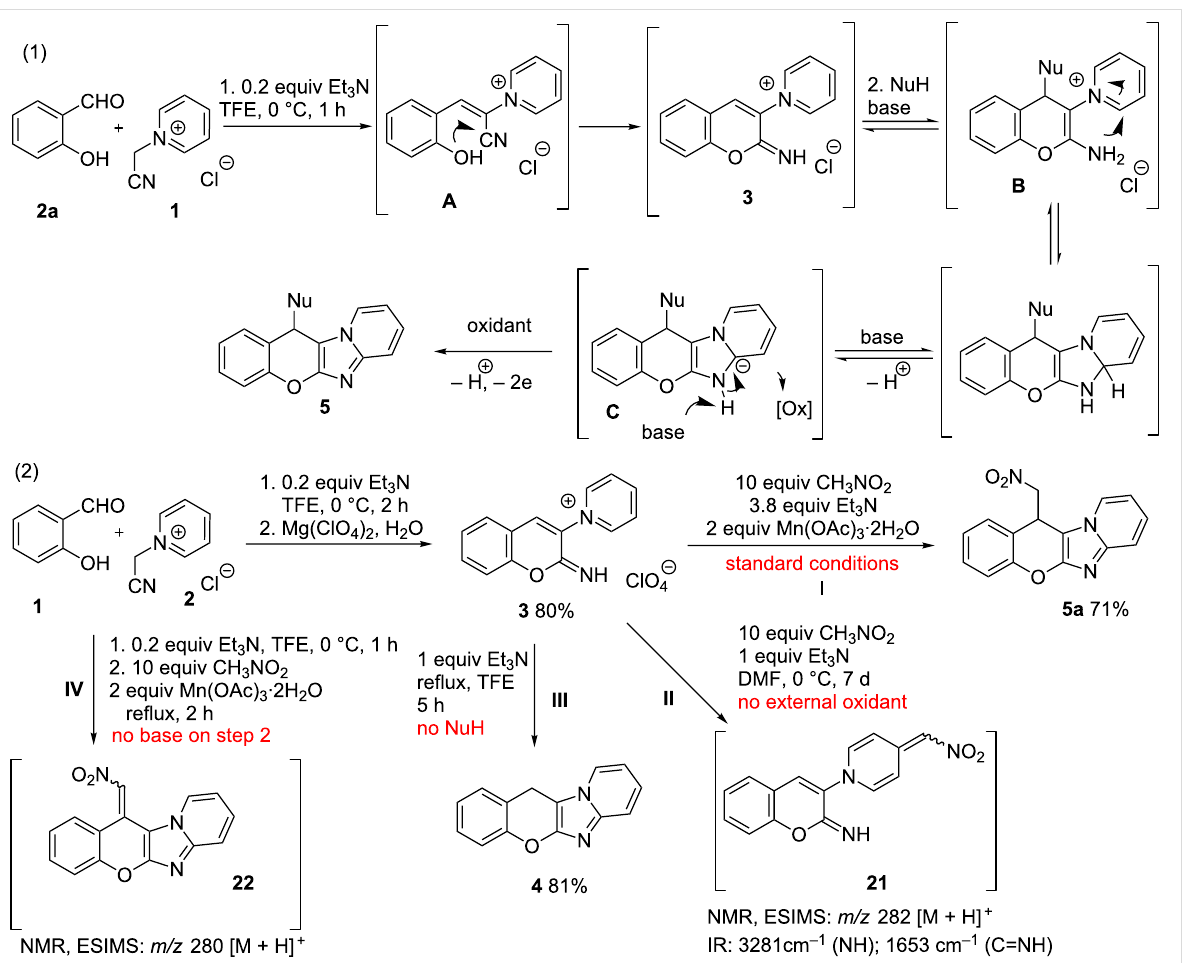
Scheme 6: The presumed mechanism for the formation of target chromenoimidazopyridines (reaction 1) and additional experiments for mechanism elucidation (reaction 2).